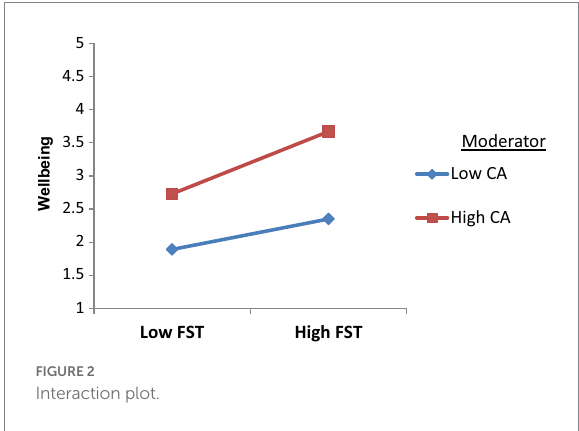
FIGURE 2 Interaction plot.